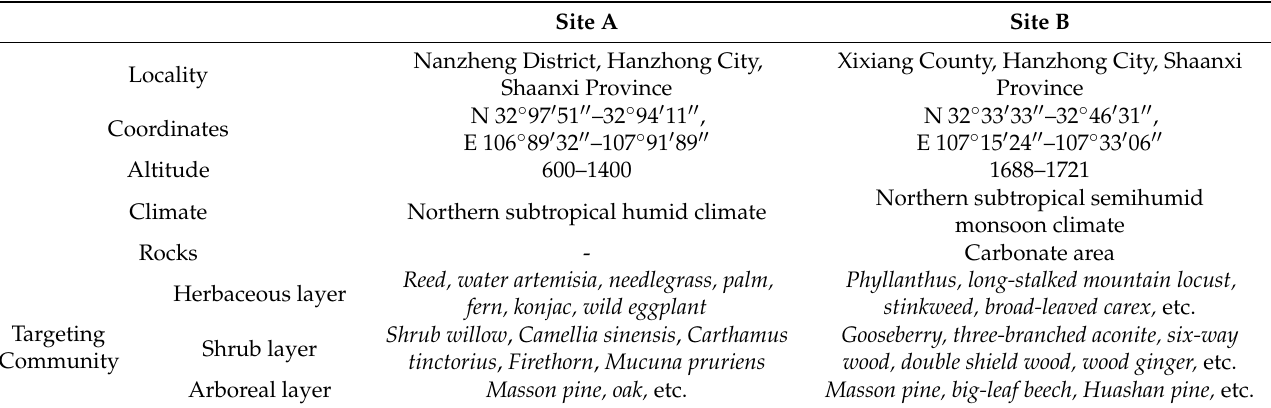
Table 6. Table of the main characteristics and the target communities of the site survey.